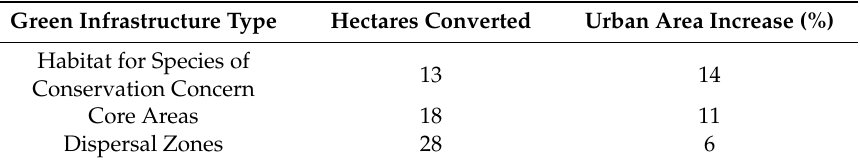
Table 4. Areal (ha) and percentage amounts of urban land-cover increase in the three ecologically significant categories of Stockholm City’s green infrastructure between 2003 and 2018.